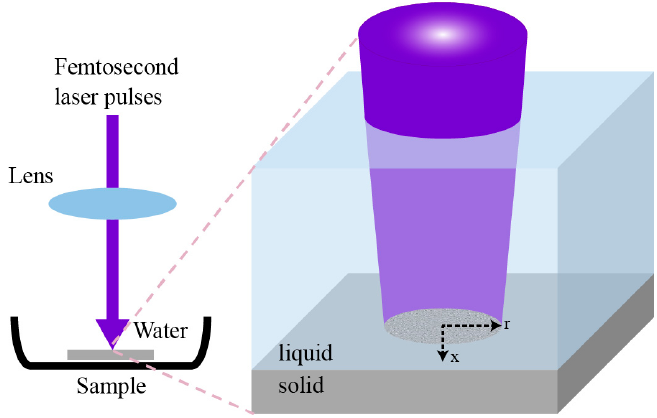
Figure 1. Scheme of femtosecond laser irradiation process.